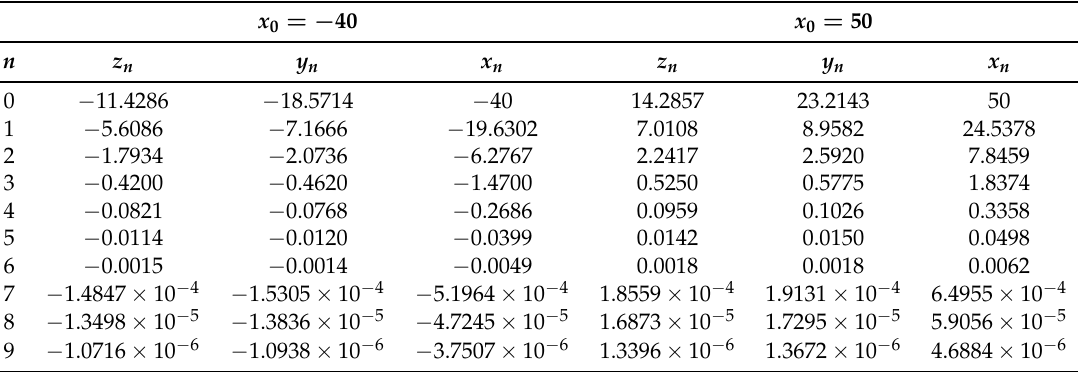
Figure 2. Values of (cid:107) x n + 1 − y n (cid:107) and x n . Table 1. The convergence of Algorithm